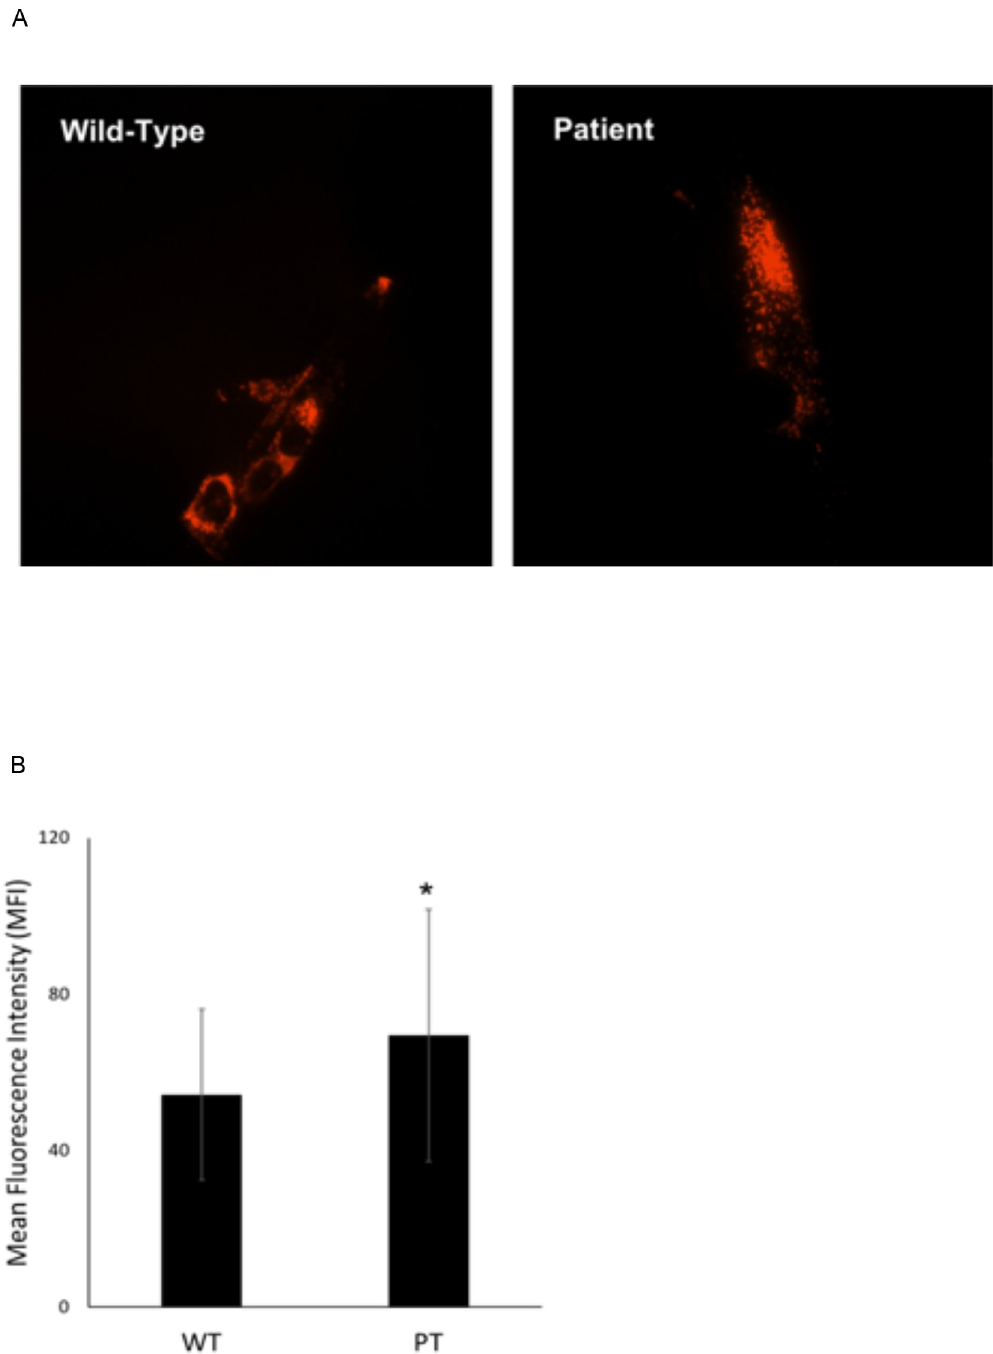
Fig 5. A. LAMP1 signal in early passage (P3) WT and PPT patient fibroblasts. Cells were stained with LAMP1 antibody and imaged using a Texas Red (ex 596nm / em 620nm) filter for fluorescence microscopy. LAMP1 signal was greater in PPT patient cells compared to WT (p < 0.01). B. Quantitative analysis of LAMP1 signal in early passage PPT patient and WT fibroblasts. Average LAMP1 signal intensity was measured using ImageJ (n = 40–60 cells for both groups). A significant 1.3-fold increase ( � , p < 0.01) in mean fluorescence intensity (MFI) was found in PT cells compared to WT. Error bars represent +/- SD.